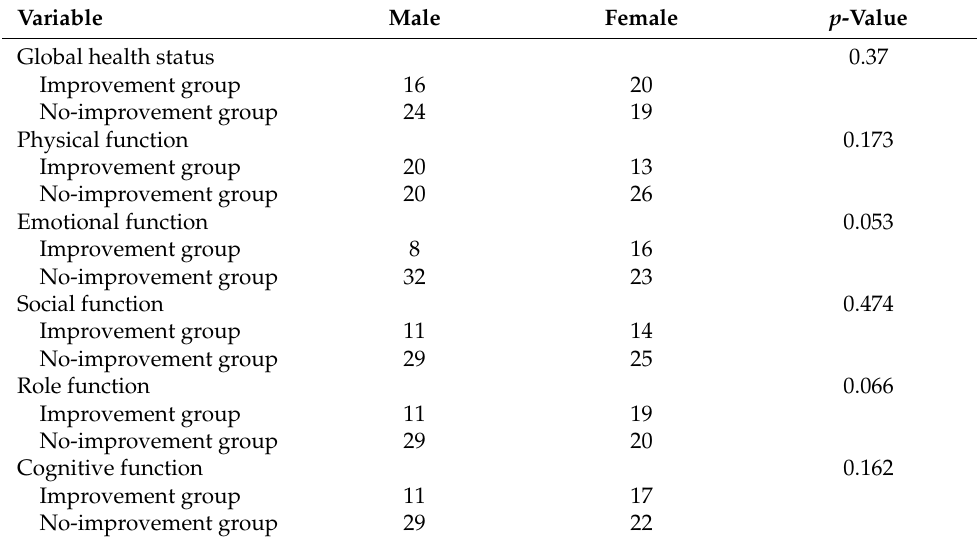
Table 2. Differences in quality of life between